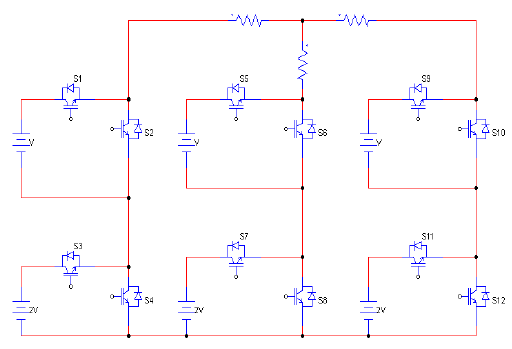
Figure 9. Circuit for seven-level cascaded MLI. Electronics 2020 , 9 , x FOR PEER REVIEW